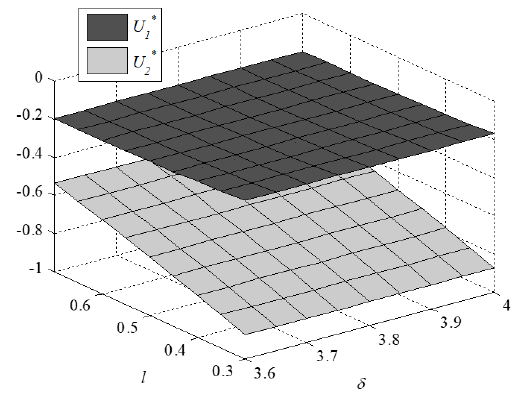
Figure 5. Changes in the utility of the consumers.